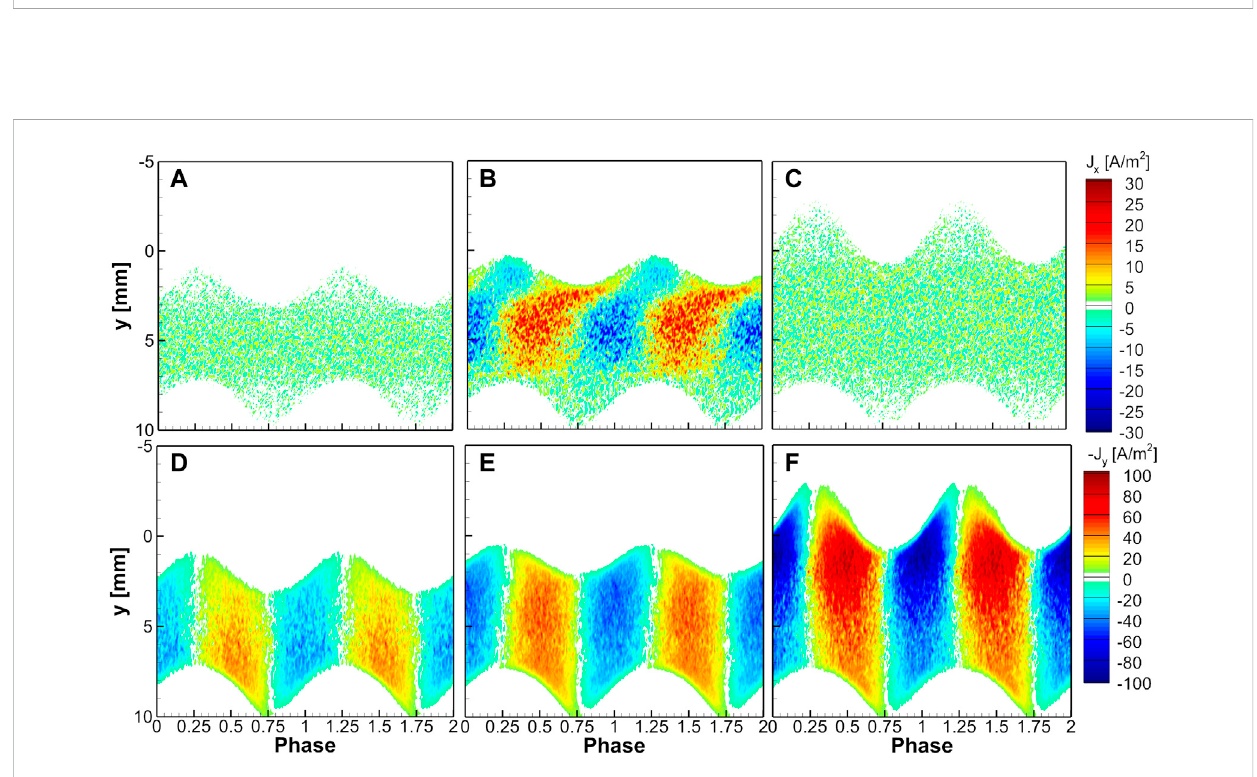
FIGURE 5 The phase-resolved electron current density for the conditions in Figure 3C for two RF periods. The electron current density (A) – (C) in the x -direction and (D) – (F) in the negative y -direction over the y -directional spatial positions at (A) , (D) x = − 7 mm, (B) , (E) x = − 3 mm, and (C) , (F) x =